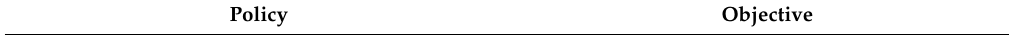
Table 2. Policies and corresponding objectives of the National Policy for the Management of Wildlife (NPMW), 2017, of Ecuador